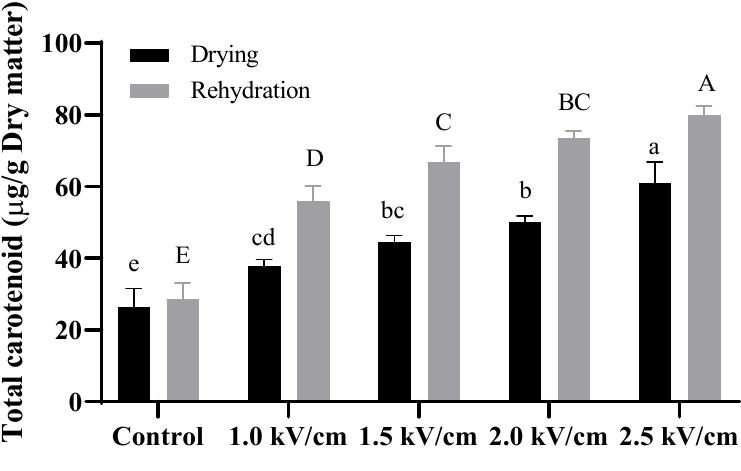
Figure 5. Total carotenoid content of dried carrot with different strengths of PEF pretreatment after dehydrated and rehydrated at 90 °C. Control: untreated; 1.0 kV/cm: carrot treated with PEF 1.0 kV/cm, 1.5 kV/cm: carrot treated with PEF 1.5 kV/cm; 2.0 kV/cm: carrot treated with PEF 2.0 kV/cm; 2.5 kV/cm: carrot with PEF 2.5 kV/cm (n = 3). Values within different lowercase letters (a–d) for drying and uppercase letters (A–C) for rehydration in the same column are significantly different ( p < 0.05) as determined by Duncan’s test.